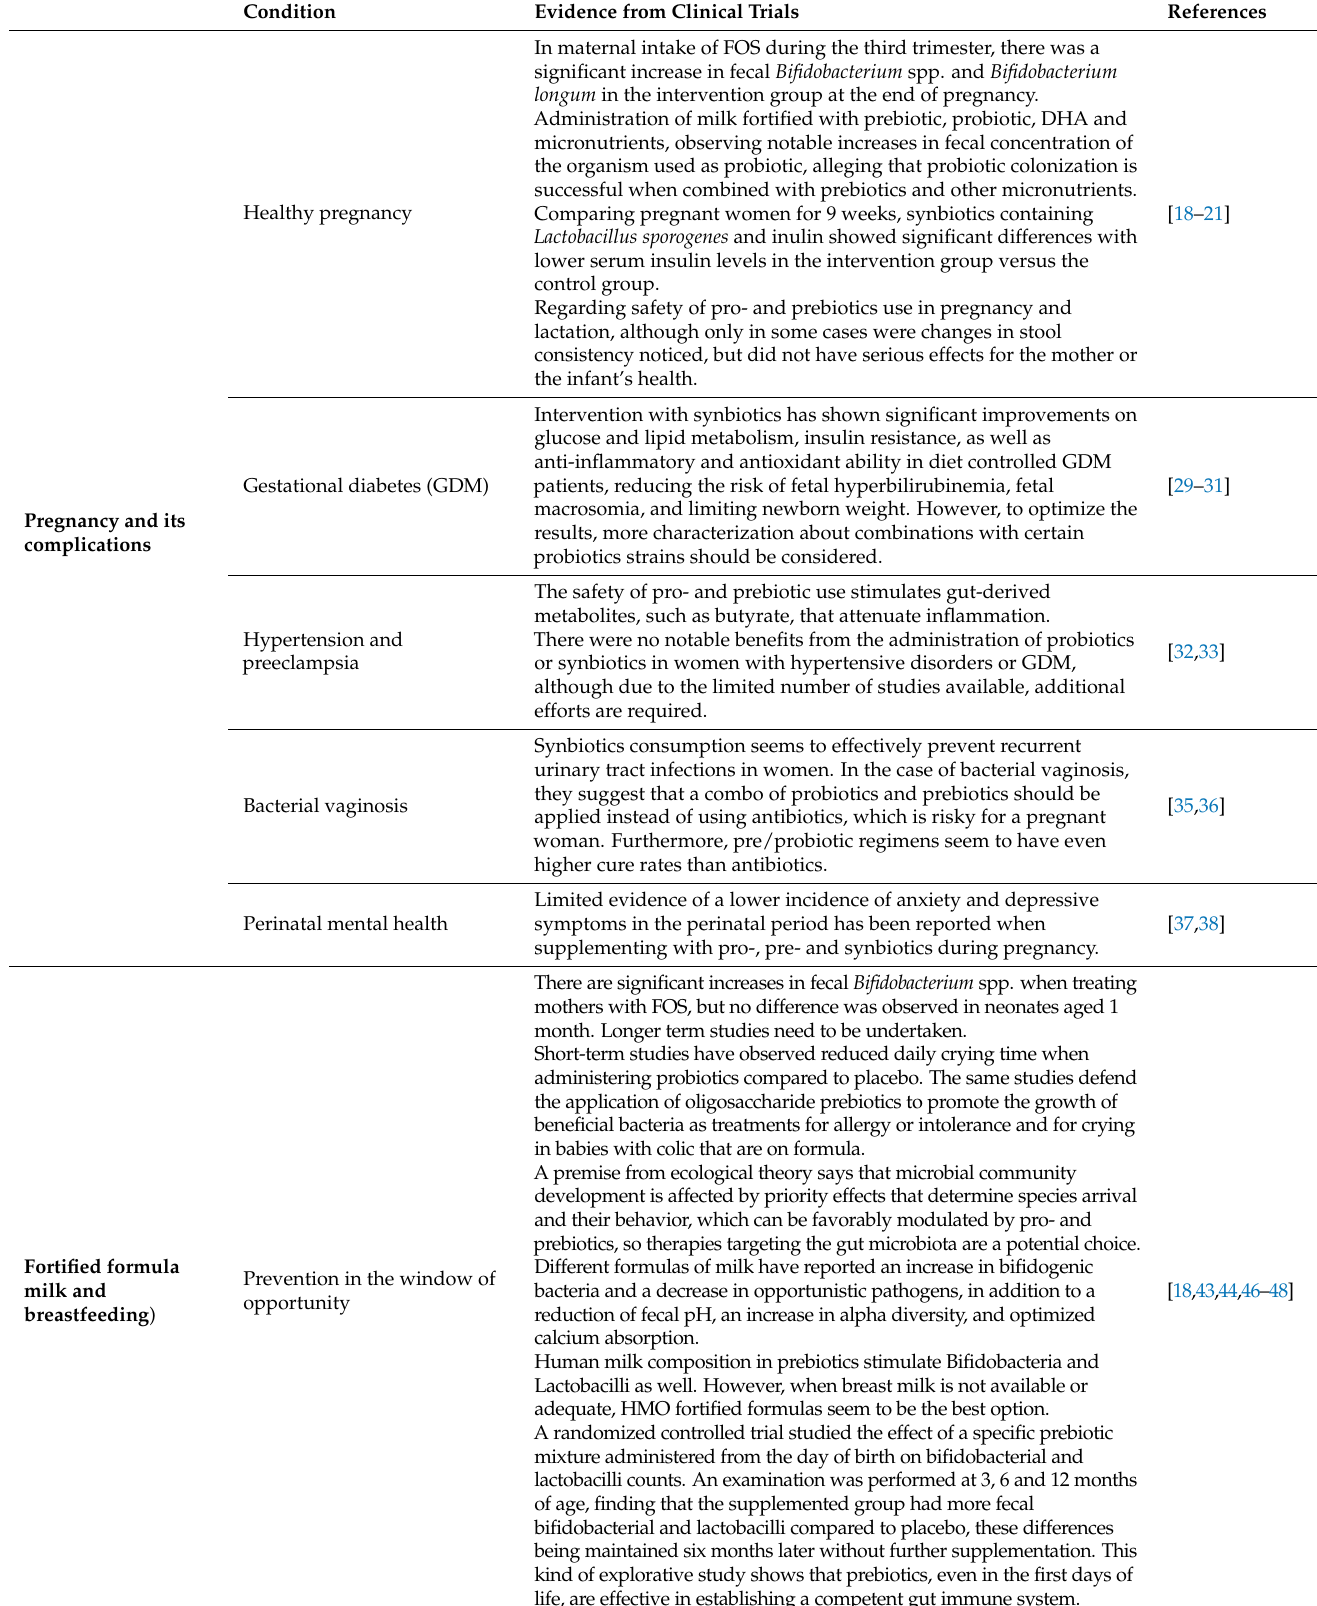
Table 1. Evidence from clinical use of prebiotics in pregnancy, its complications, lactation and pediatric